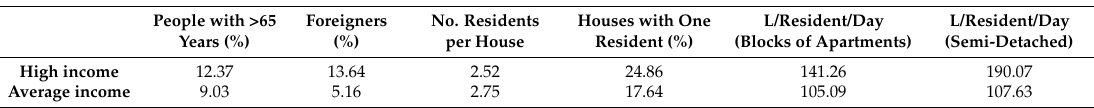
Table 4. Socio-economic characteristics of the districts of the urban periphery (blocks of apartments and semi-detached houses), 2011. Source: INE,